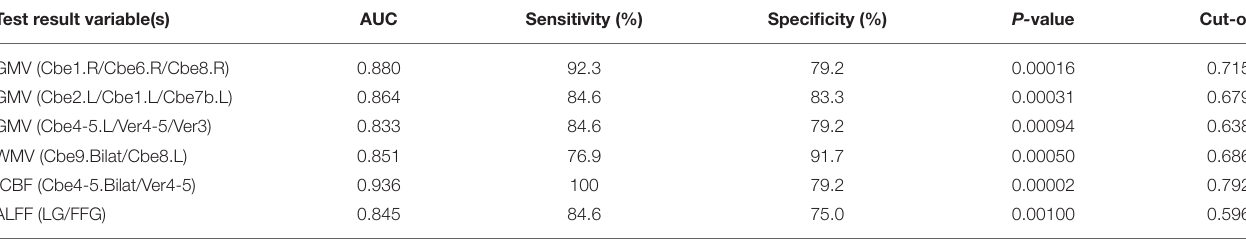
TABLE 3 | Receiver operating characteristic (ROC) curve for structure, rCBF, and functional alterations in MSA-c and MSA-p patients. Test result